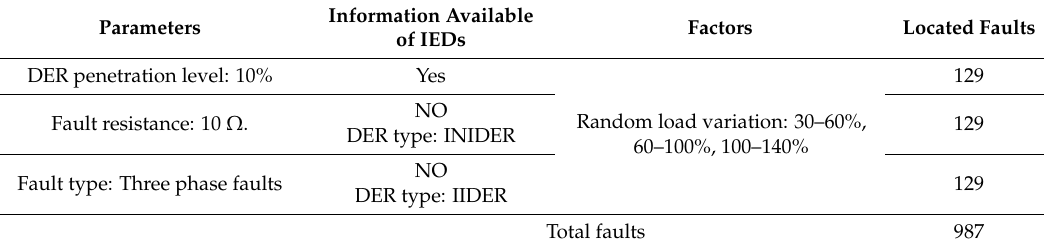
Table 2. Simulation data for scenario 2.